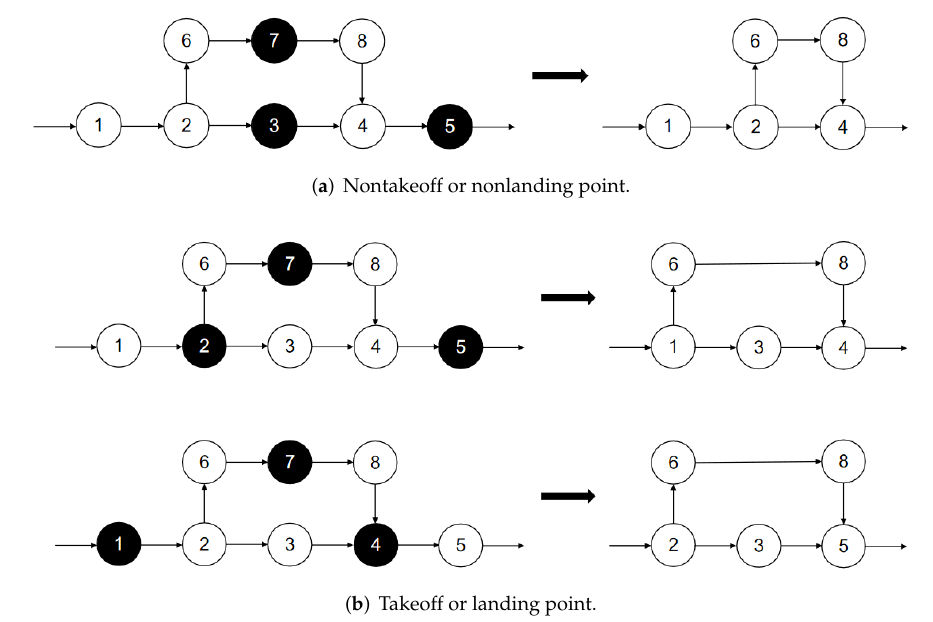
Figure 4. Schematic diagram of destroy